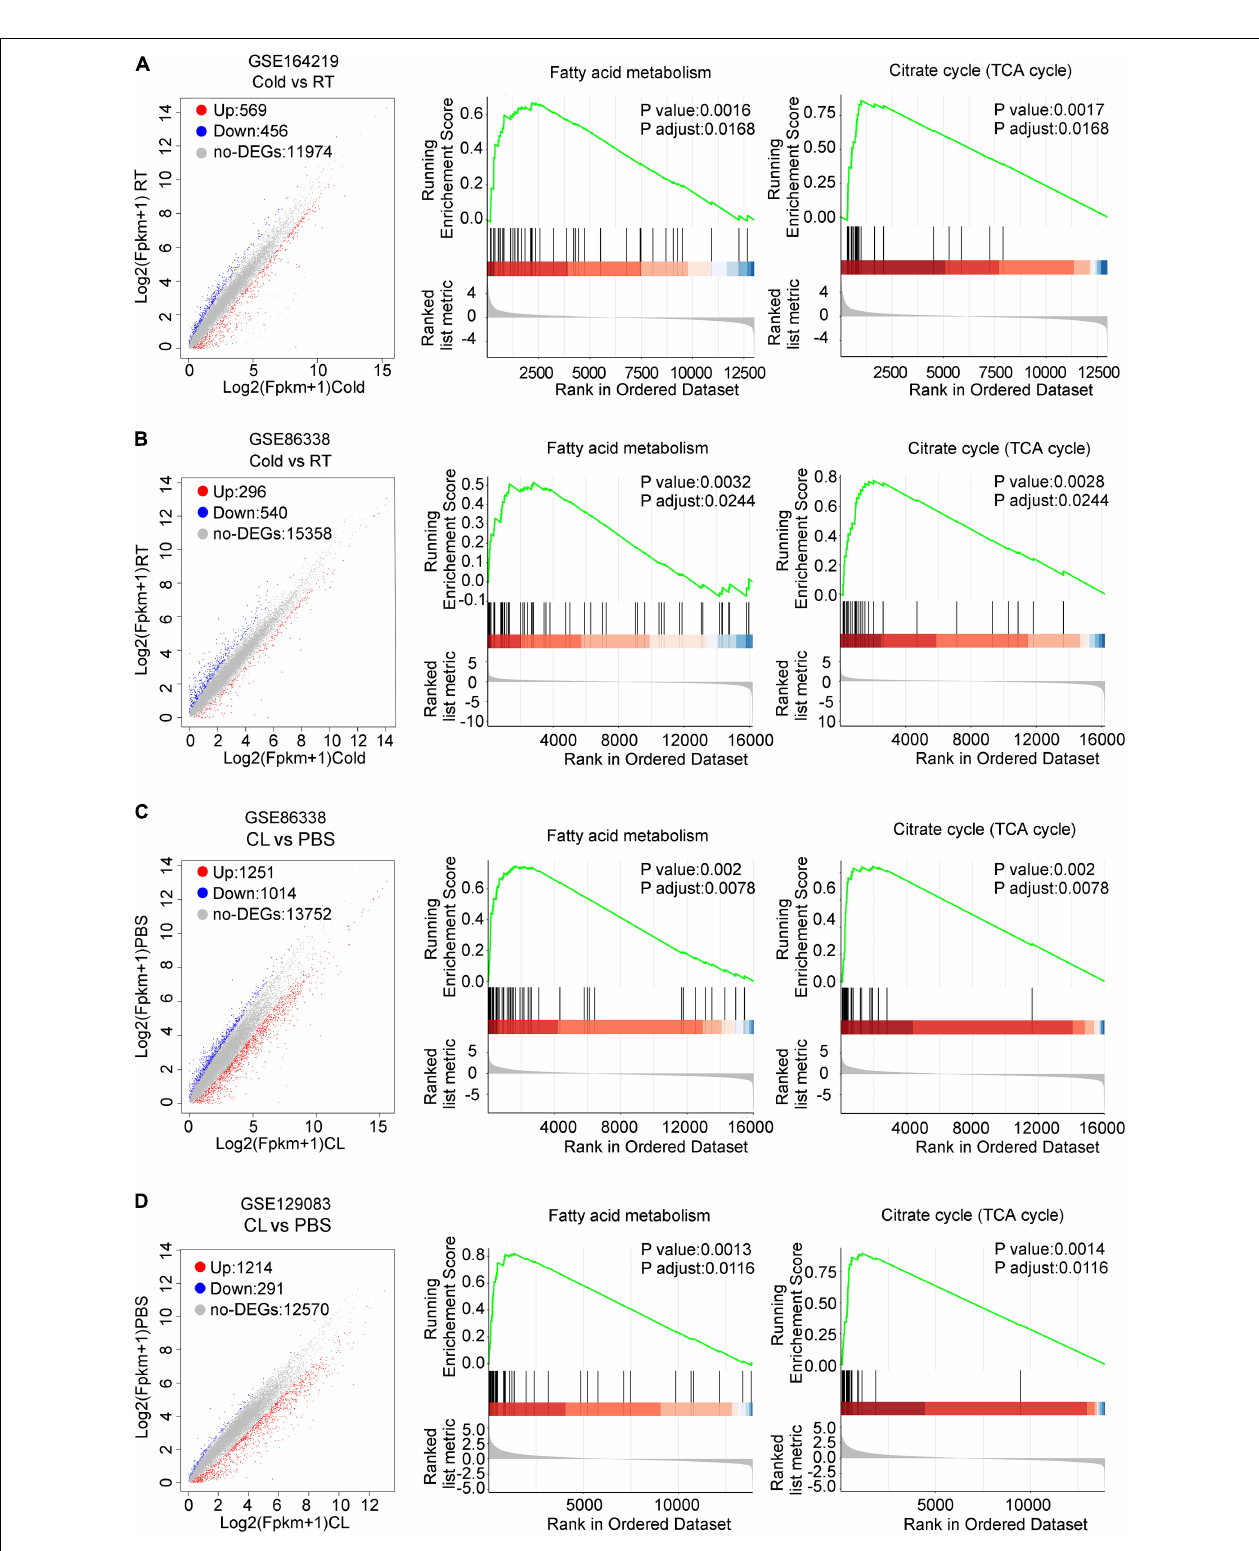
FIGURE 3 | DEGs and GSEA of RNA-seq datasets for iWAT under cold exposure or CL administration in mice. (A–D) Volcano plots for DEGs and GSEA of different datasets. (A) GSE164219 and (B) GSE86338: Cold vs. RT; (C) GSE86338 and (D) GSE129083: CL316,243 vs. PBS. Red dots for upregulated genes, blue dots for downregulated genes, and gray dots for